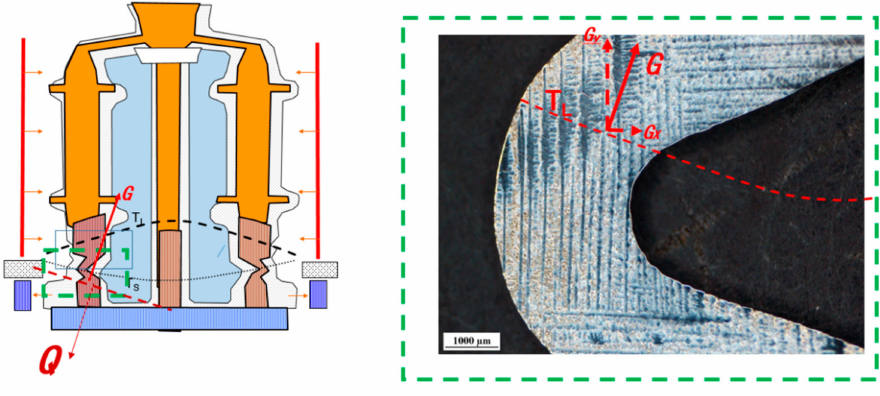
Figure 9. The 2D dendrite morphologies of overhang regions integrated with thermal profile for MM247LC.